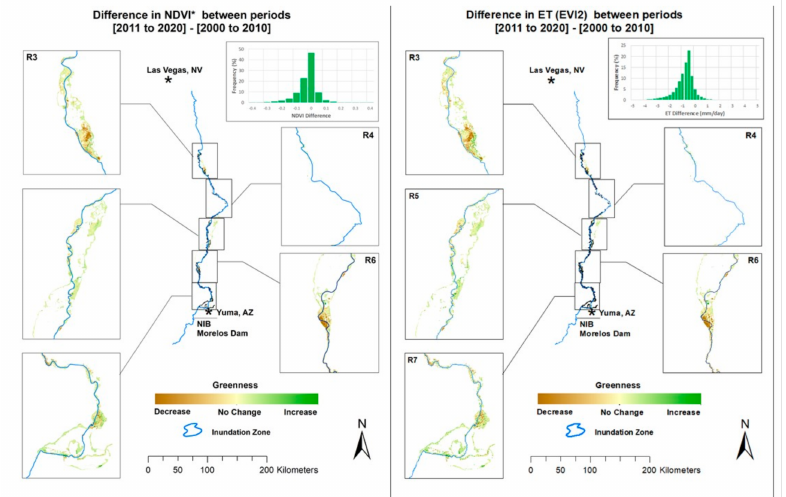
Figure 12. Maps of five reaches along the Lower Colorado River showing change in greenness using scaled NDVI (NDVI*) (12a, left) and ET (12b, right) for the compared periods of the first (2000 to 2010) and last decade (2011 to 2020). The histogram (upper right) shows the frequency of pixels. Values less than zero indicate a loss of vegetation greenness and water use. Also, each map figure contains five enlarged inset areas, boxes from north to south showing riparian vegetation in R3, R4, R5, R6, and R7. The legend shows decreases (brown) and increases (green) depicting how these two metrics, NDVI* and ET, have changed over the respective time periods.